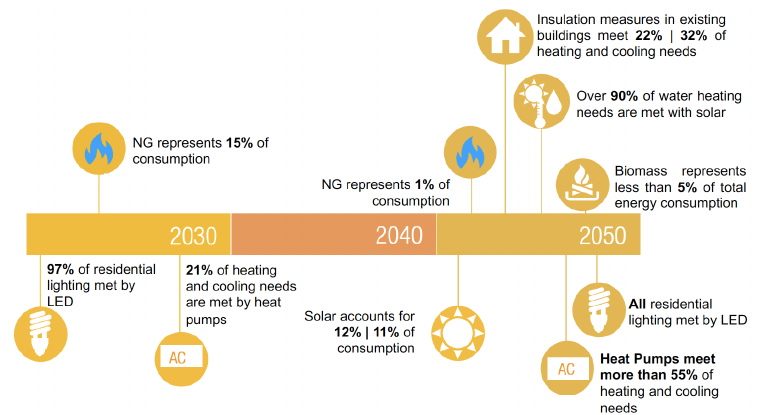
Figure 3. Timeline of residential sector’s carbon neutrality pathway up to 2050, as defined by the RNC2050, adapted with permission from Ref. [33].